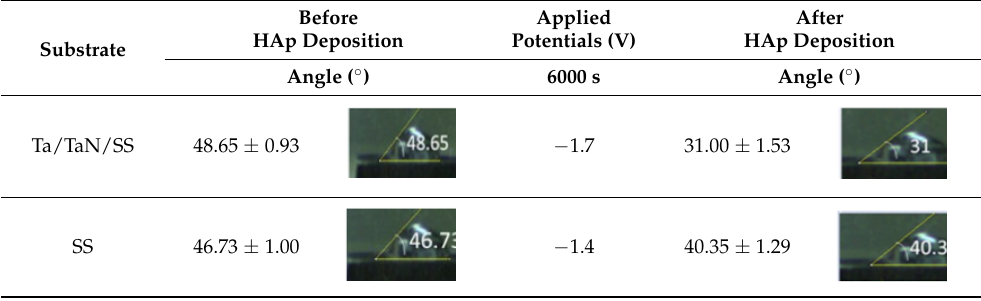
Table 3. Contact angle measurements on the different substrates with HAp